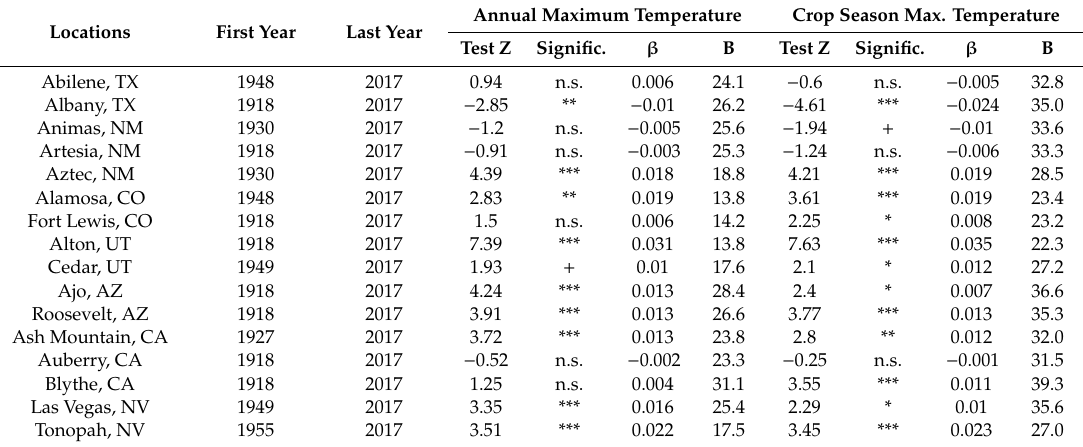
Table 3. Summary of the Mann–Kendall trend test for annual and crop season maximum temperature.